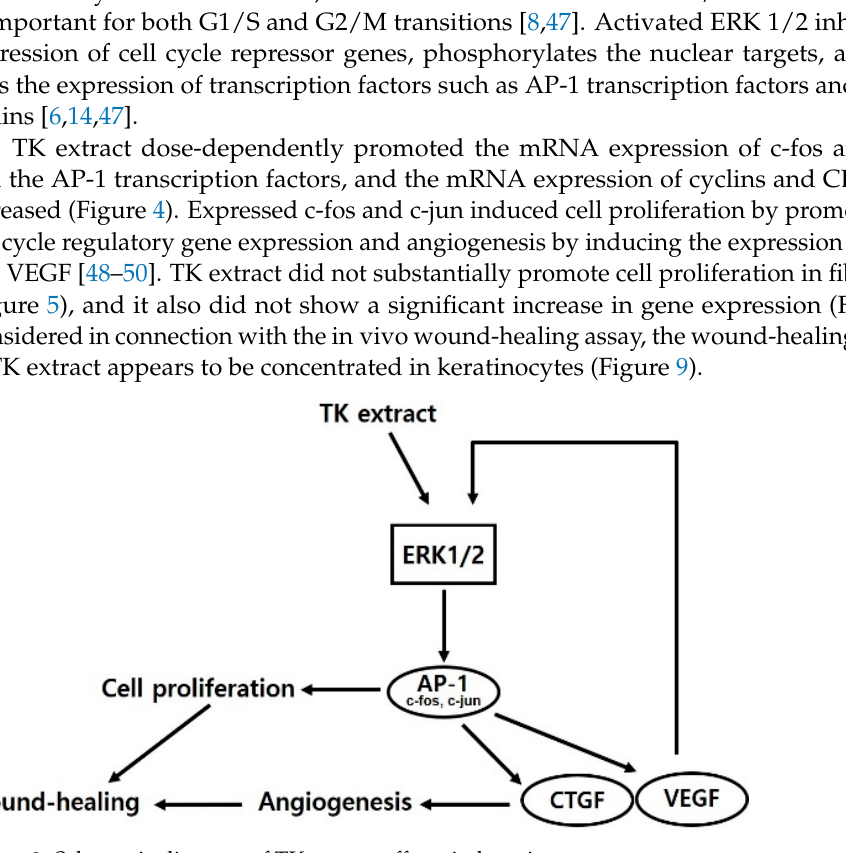
Figure 9. Schematic diagram of TK extract effects in keratinocytes.